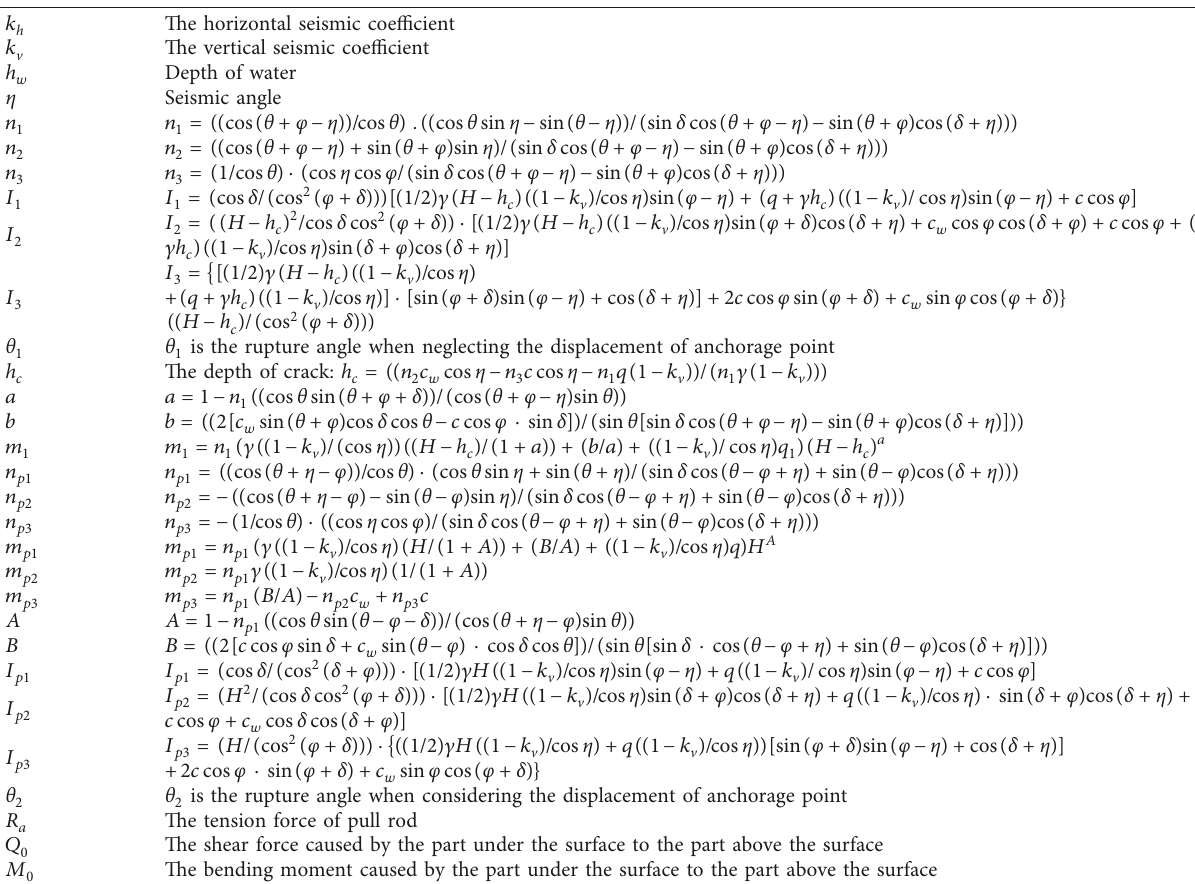
Table 3: The symbols in Table